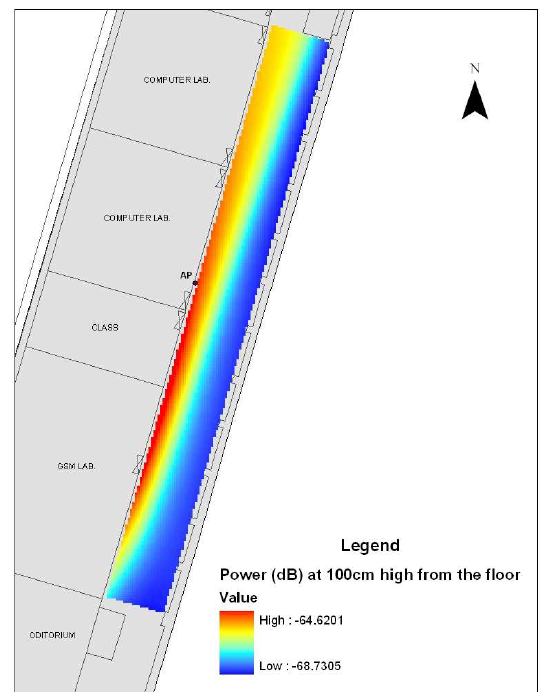
Figure 11. ANN prediction of received power (dB) values at the 100 cm height